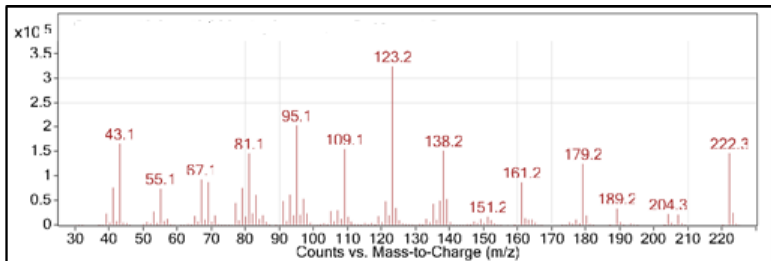
Figure 2. Mass spectrum of faurinone.